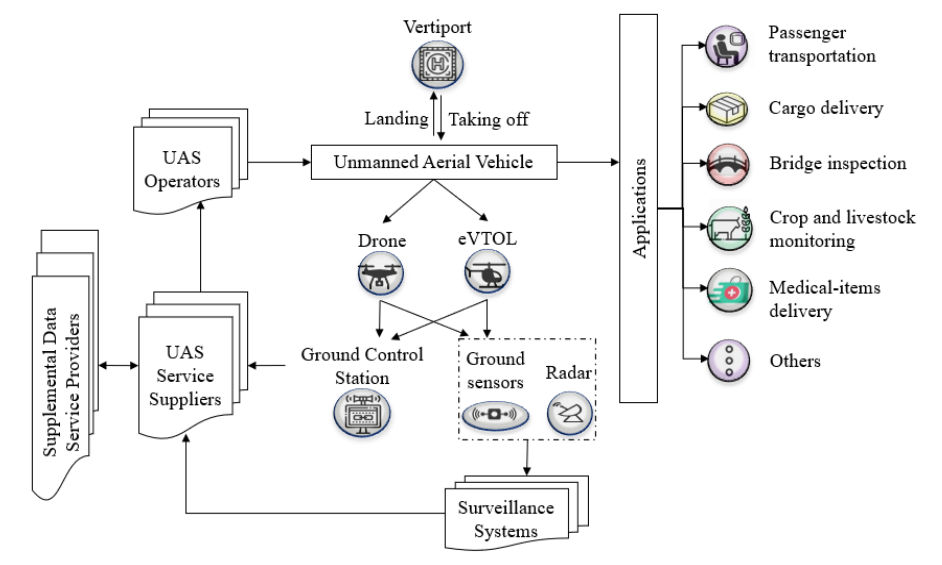
Figure 1. Notional AAM